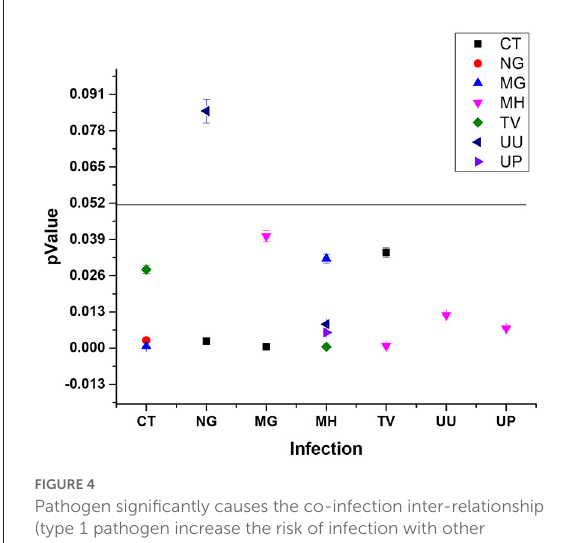
chorioamnionitis, postpartum endometritis and stillbirth (Figure